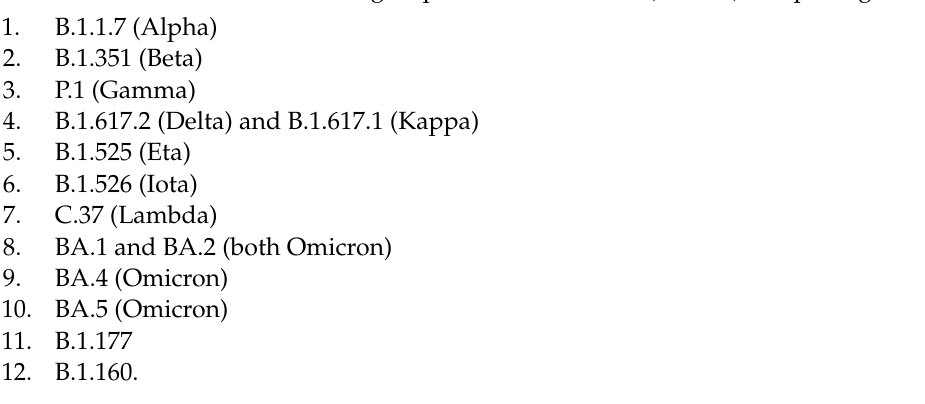
Table 1. Details of proteome samples of SARS-CoV-2 variants obtained from NCBI. Number of Nextstrain Clade Pango Lineage WHO Label